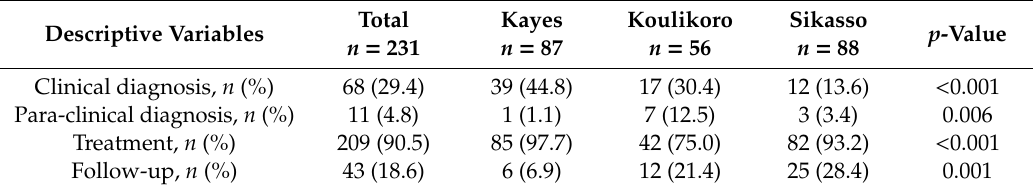
Table 4. Reasons for collaboration between the traditional healers and modern